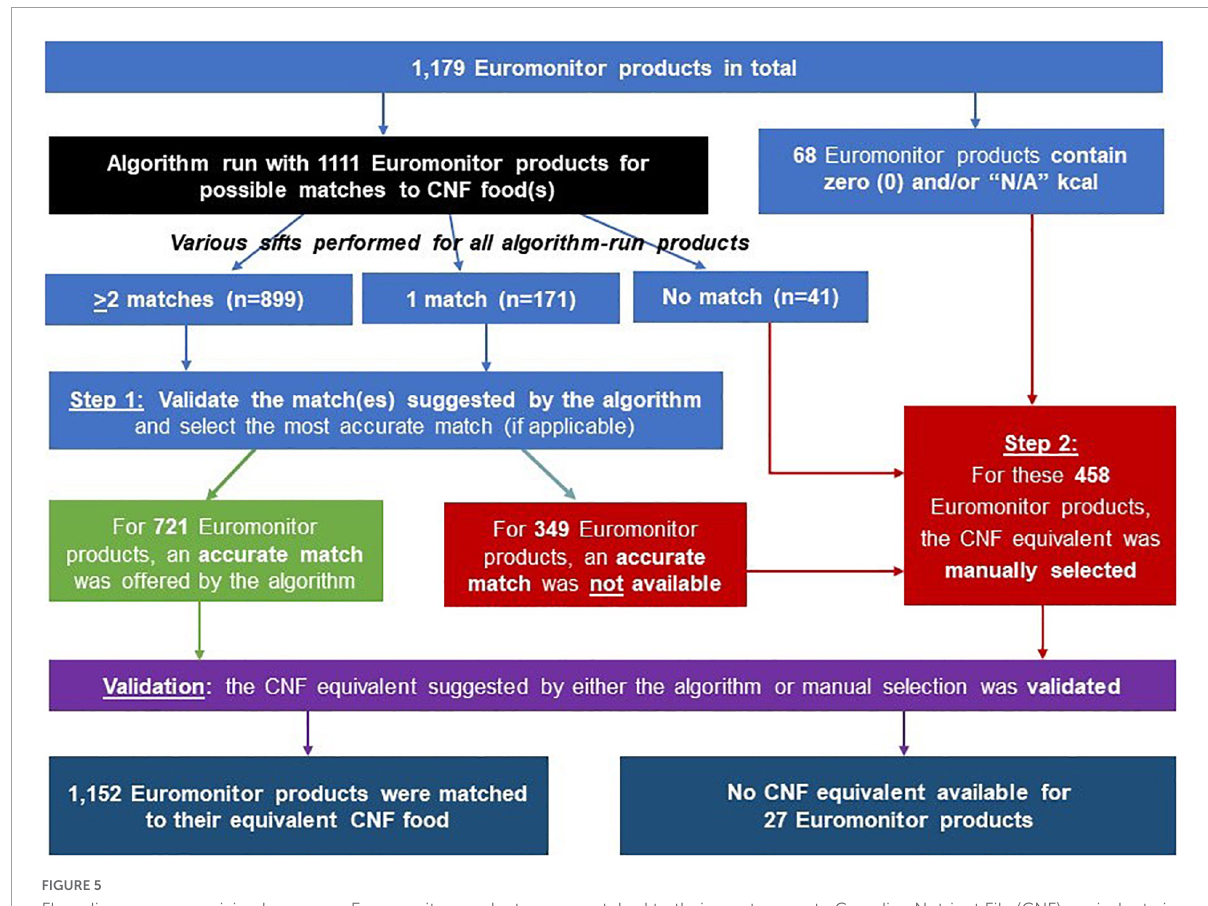
FIGURE5 Flow diagram summarizing how many Euromonitor products were matched to their most accurate Canadian Nutrient File (CNF) equivalent via the algorithm-based and manual selection